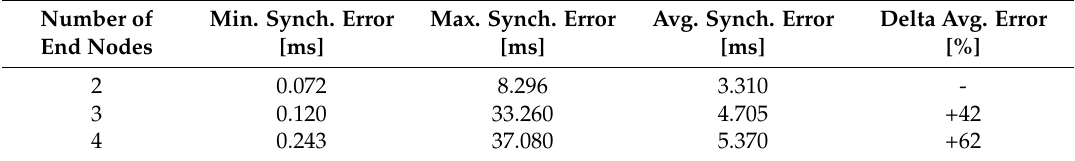
Table 1. Results of the measurements carried out to verify the RTC synchronization between multiples end node connected to a single